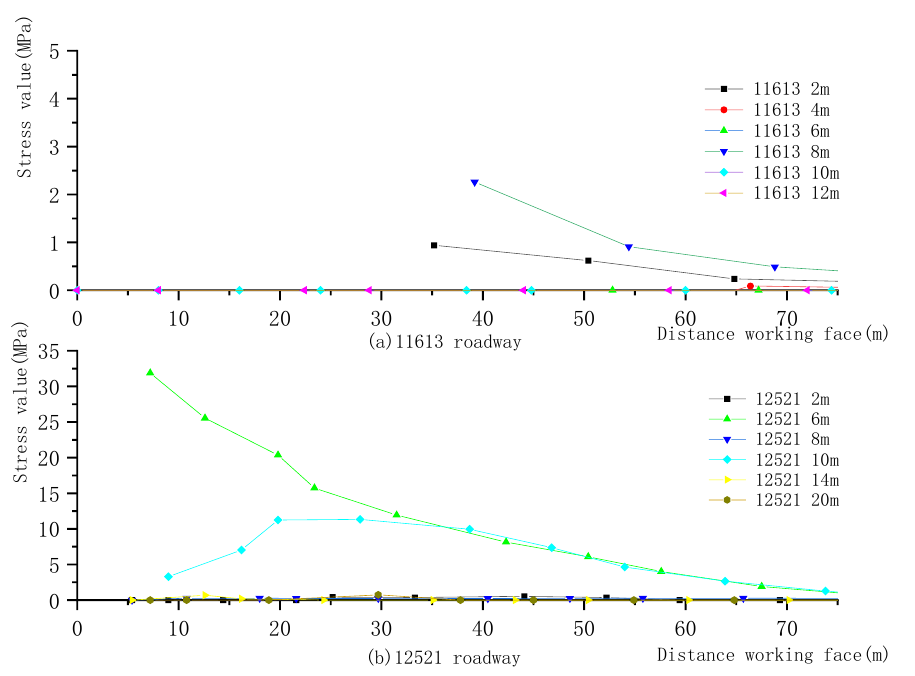
Figure 15. Comparison analysis diagram of horizontal stress increment of low side within 75 m. ( a ) 11613 roadway; ( b ) 12521 roadway.